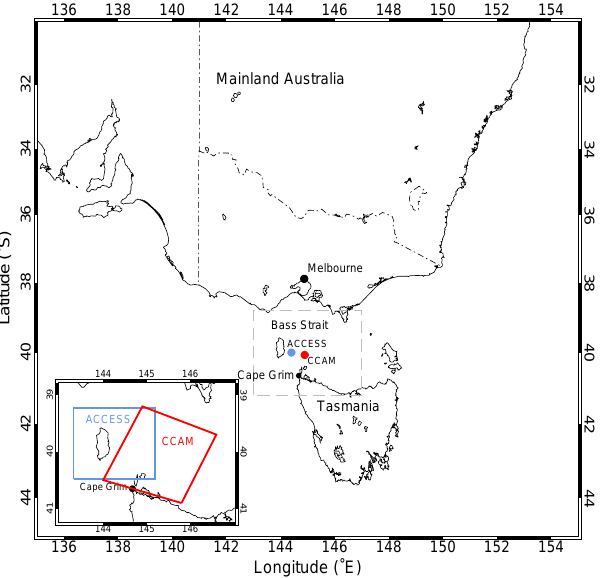
Figure 1. Map of southeastern Australia, showing the location of the Cape Grim Baseline Air Pollution Station, along with the AC- CESS (blue) and CCAM (red) grid points selected to best represent Cape Grim. The choice of these grid points is discussed in Sect. 4.2. The inset shows the extent of each of the grid